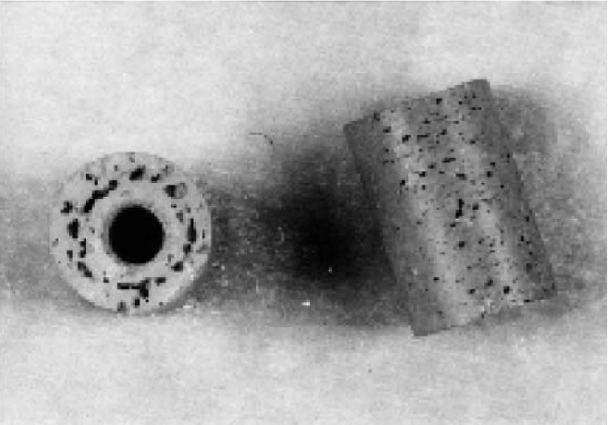
Figure 12. Sintered parts with many pores due to quick thermal debinding. Reproduced with permission from reference [97], copyright © 2004 Elsevier